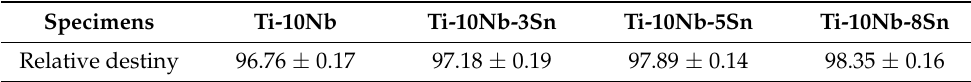
Table 1. Relative destiny of PM-fabricated Ti-10Nb-xSn alloys.